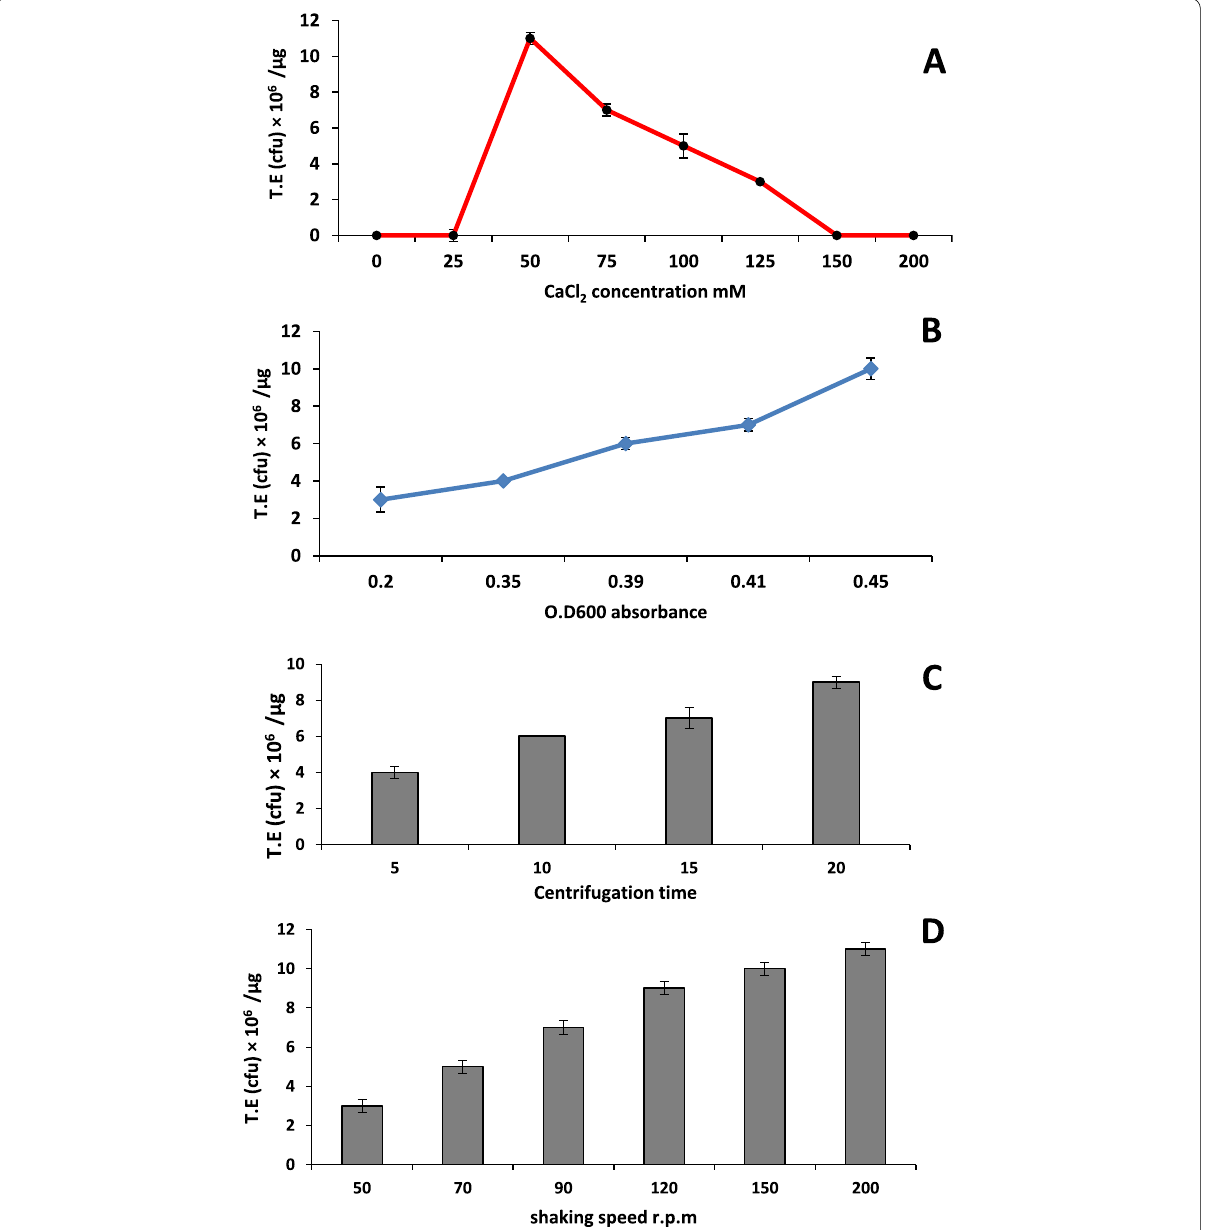
Fig. 1 Optimization for plasmid transformation. a CaCl2 concentrations. b Different absorbance values. c Different centrifugation time. d Different shaking speeds. TE, transformation